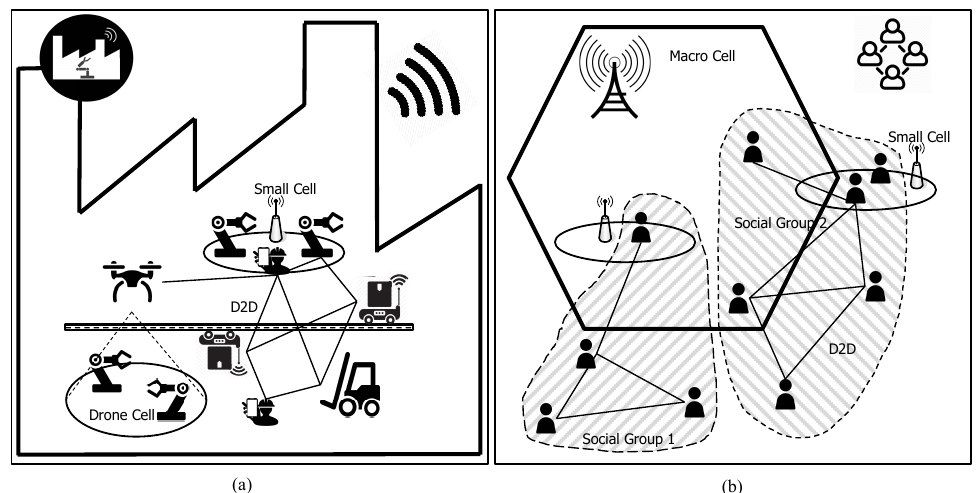
Figure 1. 5G D2D Based Smart Applications with Mobility and LLC Issues: ( a ) The Smart Factory Scenario and ( b ) The Social Networking